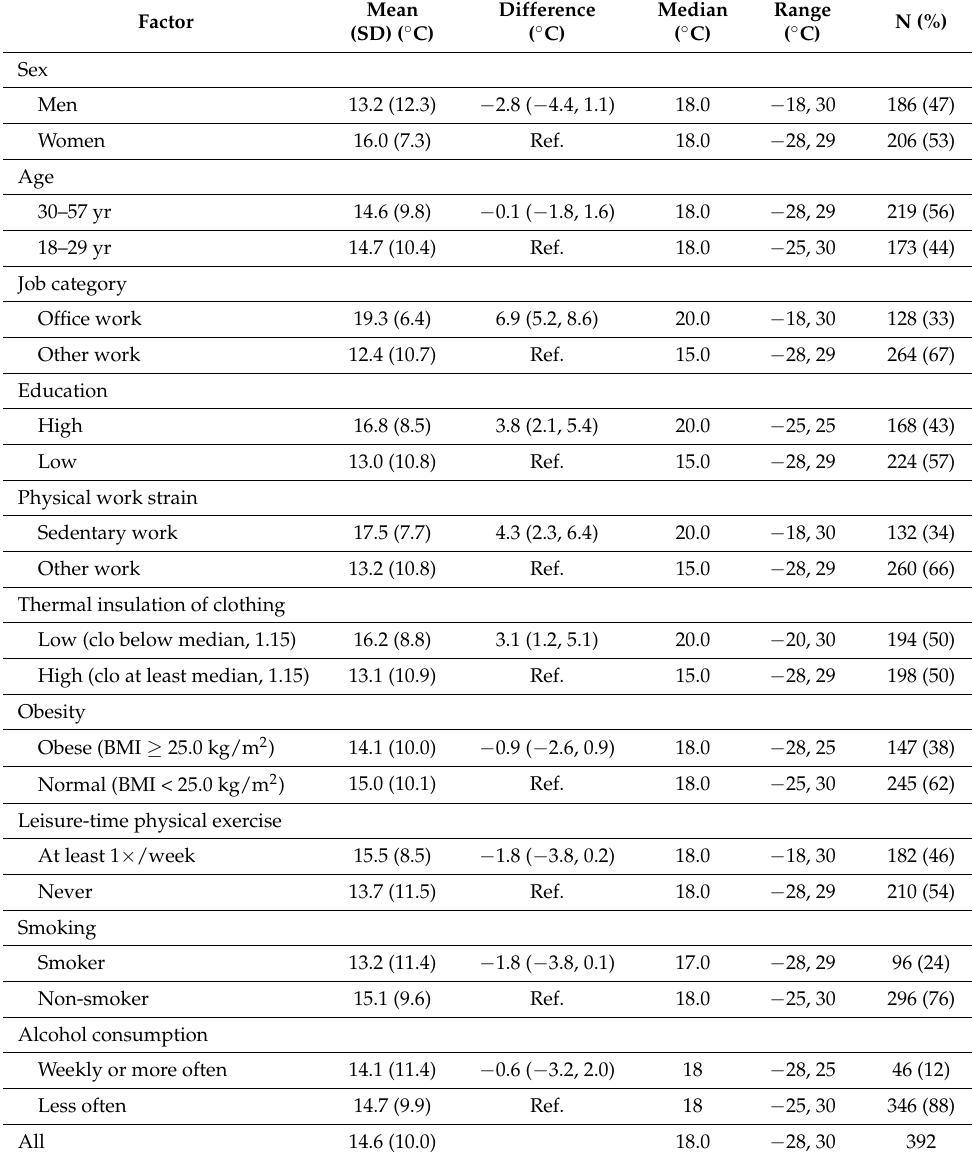
Table 1. Self-assessed threshold for cold temperature according to personal and workplace